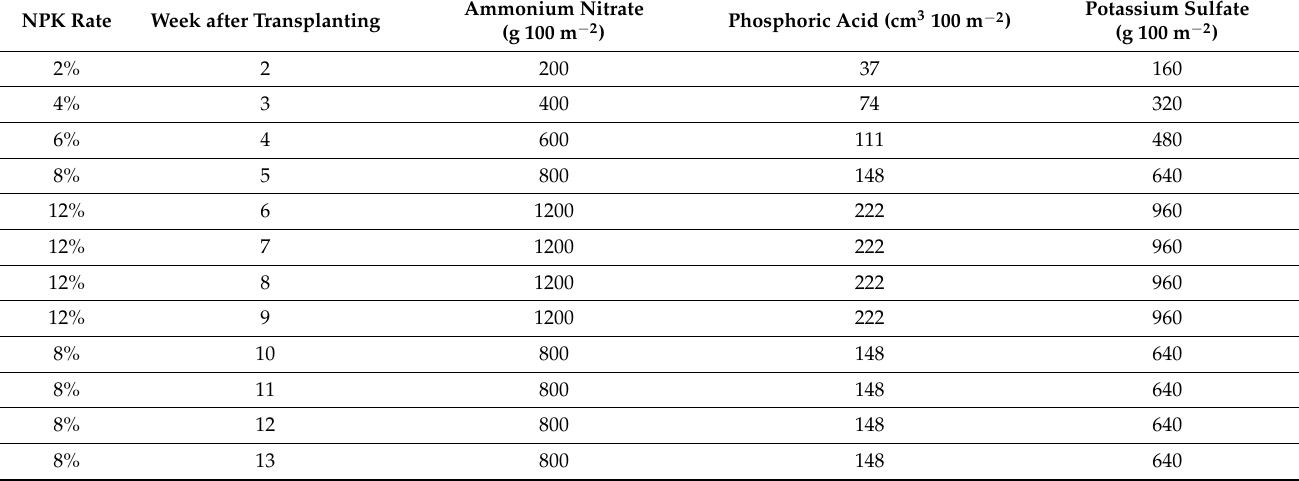
Table 4. Schedule of fertigation system (100% conventional N, P, K mineral fertilizer as a control treatment) applied for cucumber grown in loamy soil during the two growing seasons of 2017 and 2018 under a